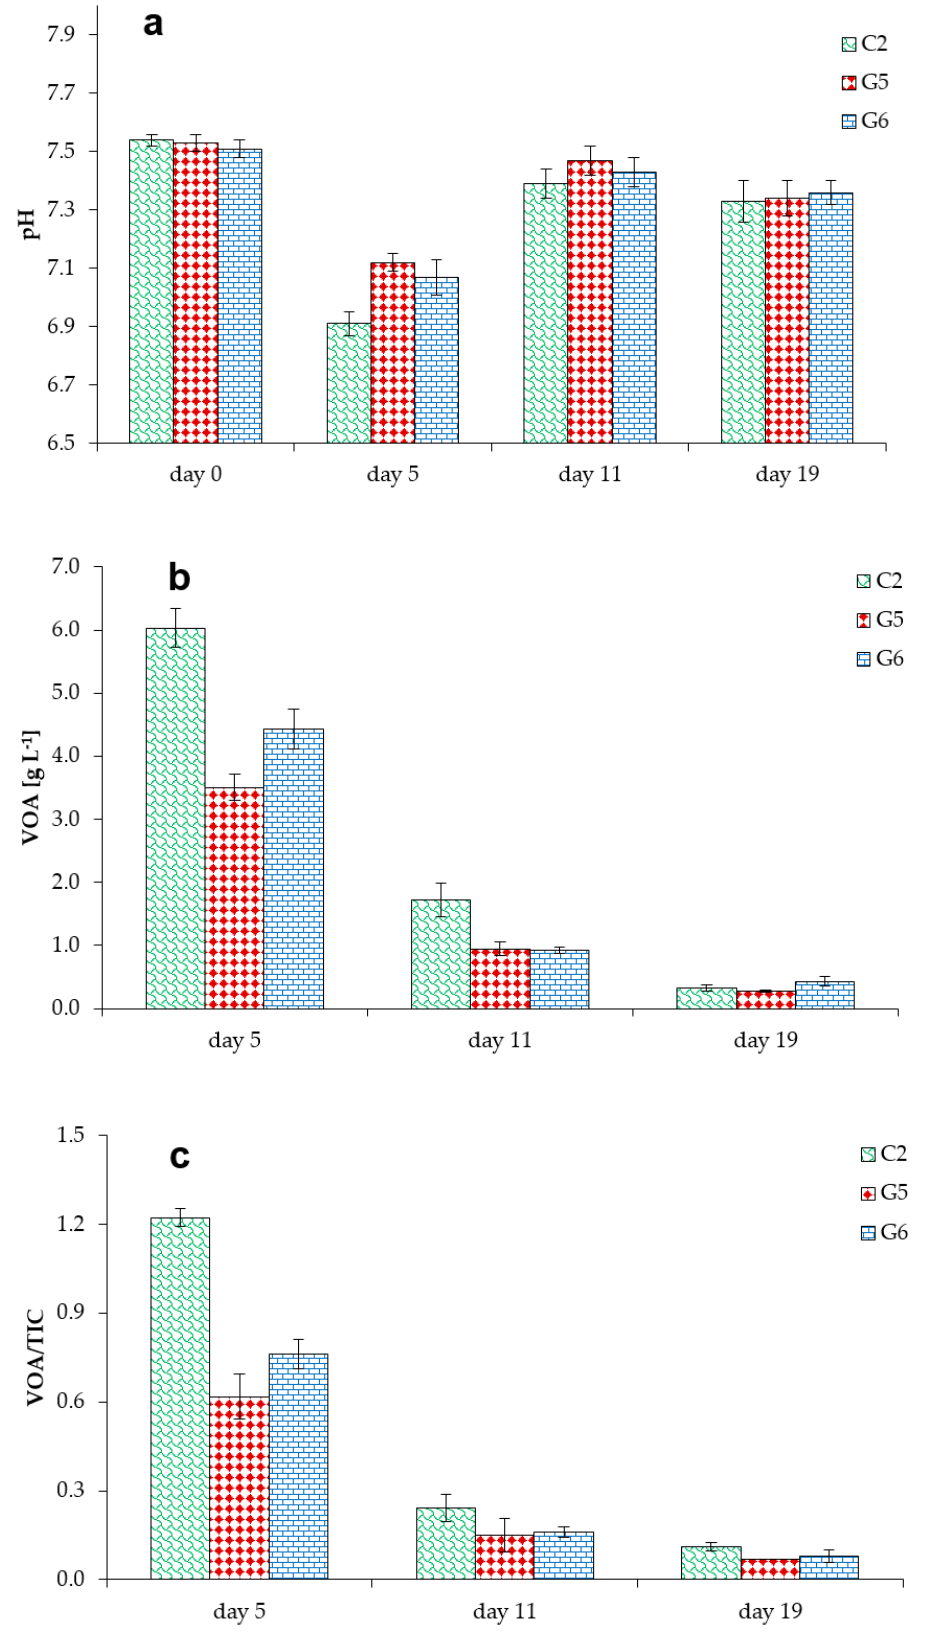
Figure 4. E ff ects of GAC addition on pH changes ( a ), VOA concentrations ( b ), and VOA / TIC ( c ) during the experimental period (ISR is 1.33). Di ff erent concentrations of GAC (0 g L − 1 , 5 g L − 1 , and 10 g L − 1 ) were added to reactors (C2, G5, and G6,